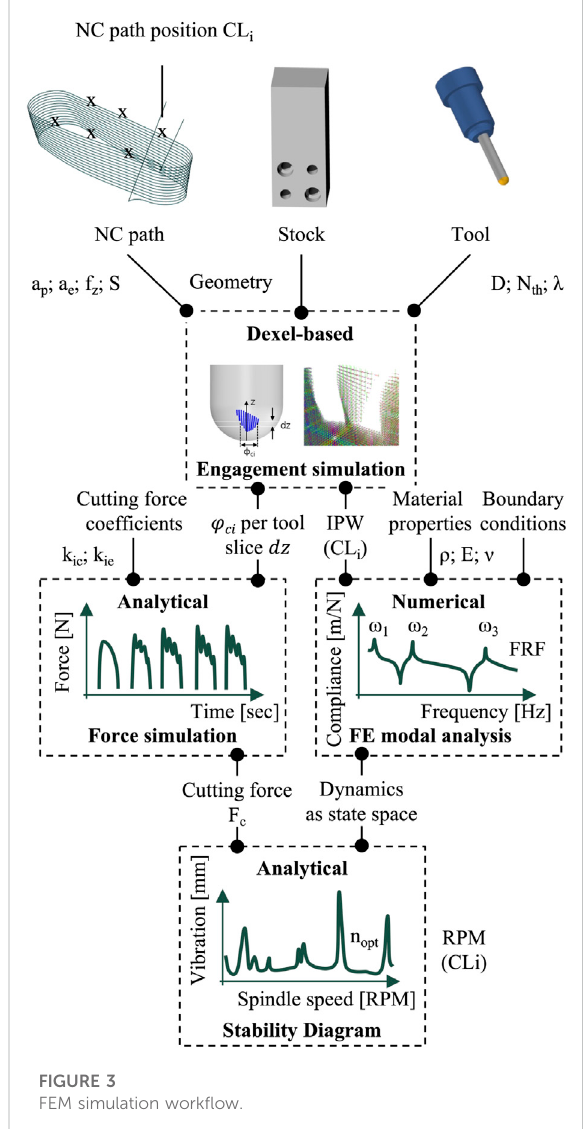
FIGURE 3 FEM simulation work fl